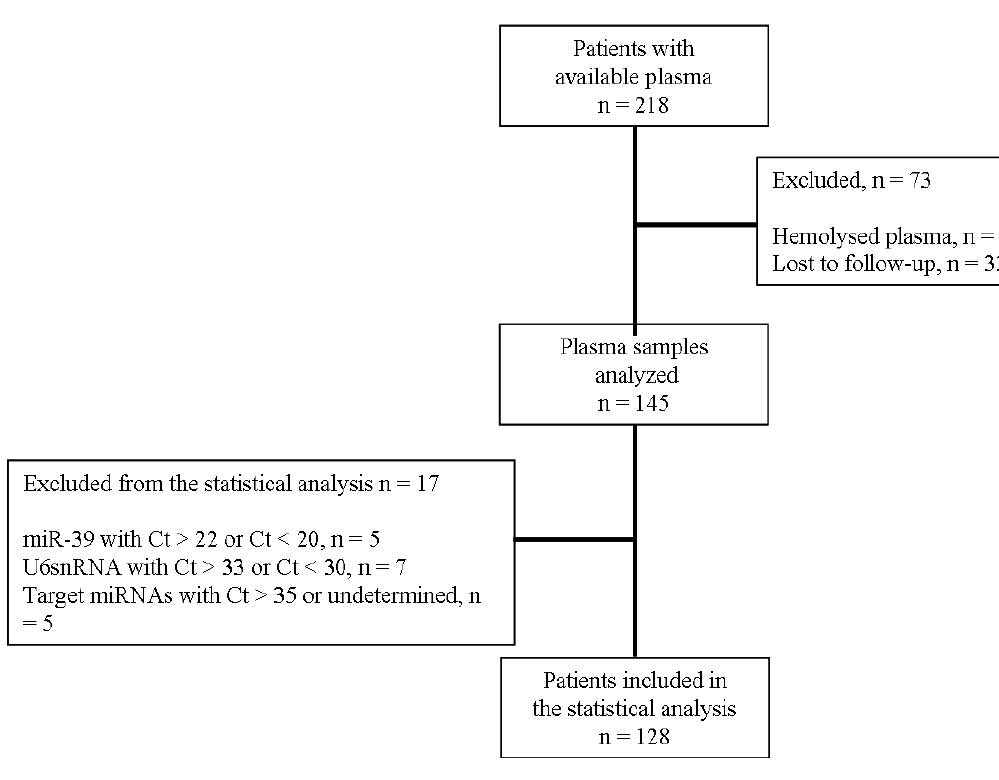
Figure 1. Flow chart of the study. Ct, cycle threshold.